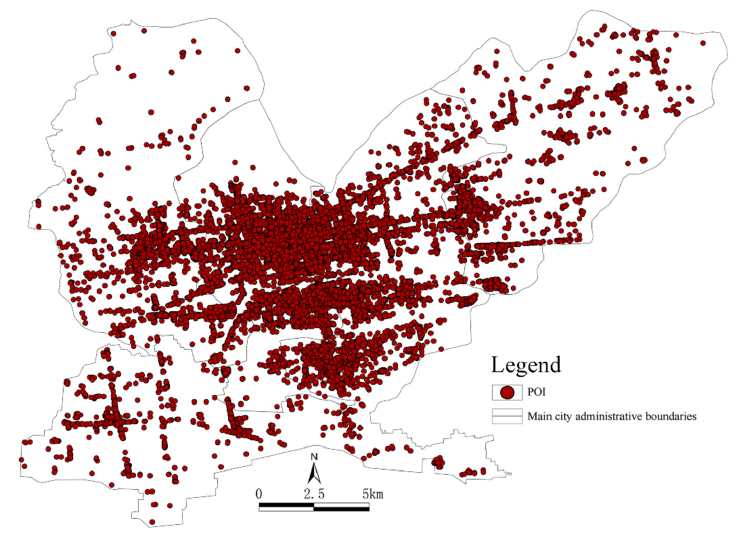
Figure 2. The distribution of POI data from the main urban area in Jiaozuo. Table 1. The classification of POI data from the main urban area in Jiaozuo.